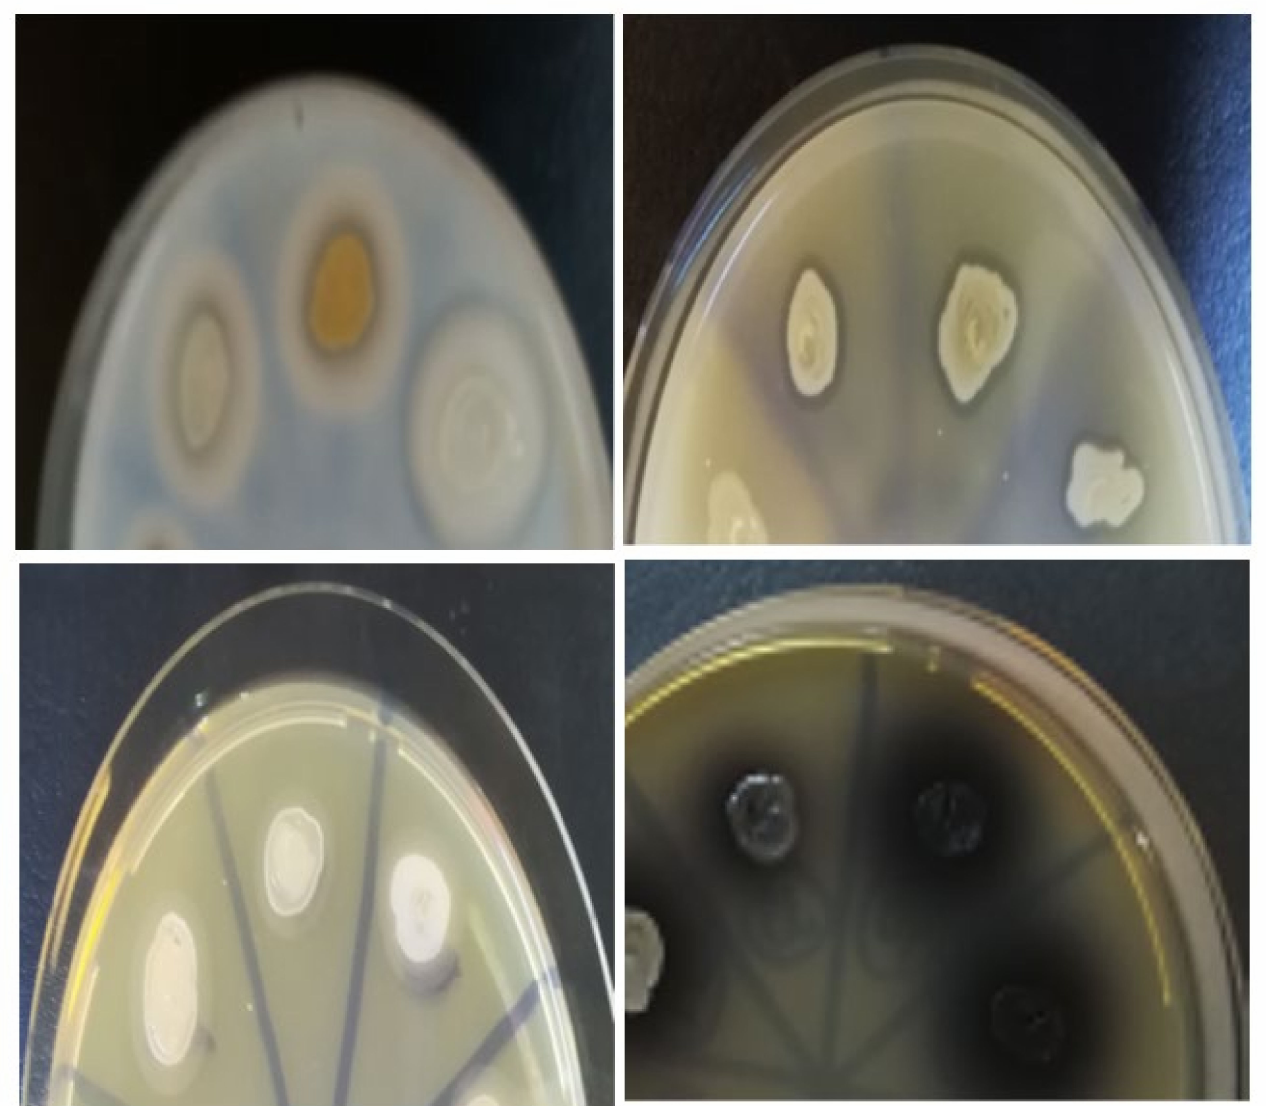
Figure 4. Aspects of expression of virulence factors on culture media: top-left—medium with casein for highlighting caseinase; right-middle—medium with lecithin to highlight lecithinase; bottom-left—medium for highlighting lipases; right—medium with esculin for highlighting the ability of the tested strains to hydrolyze